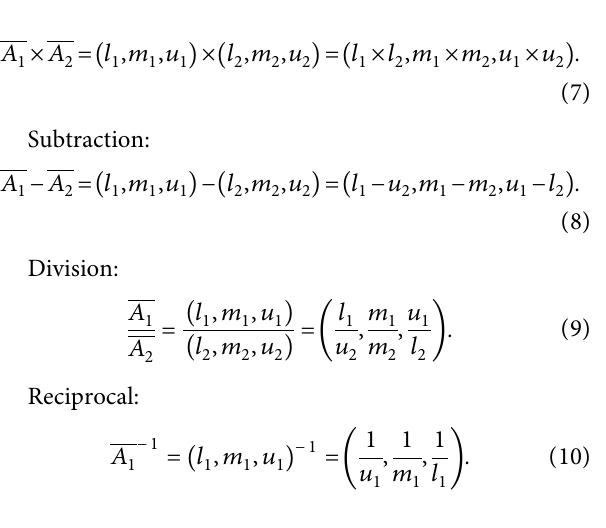
Figure 3: Methodology of the